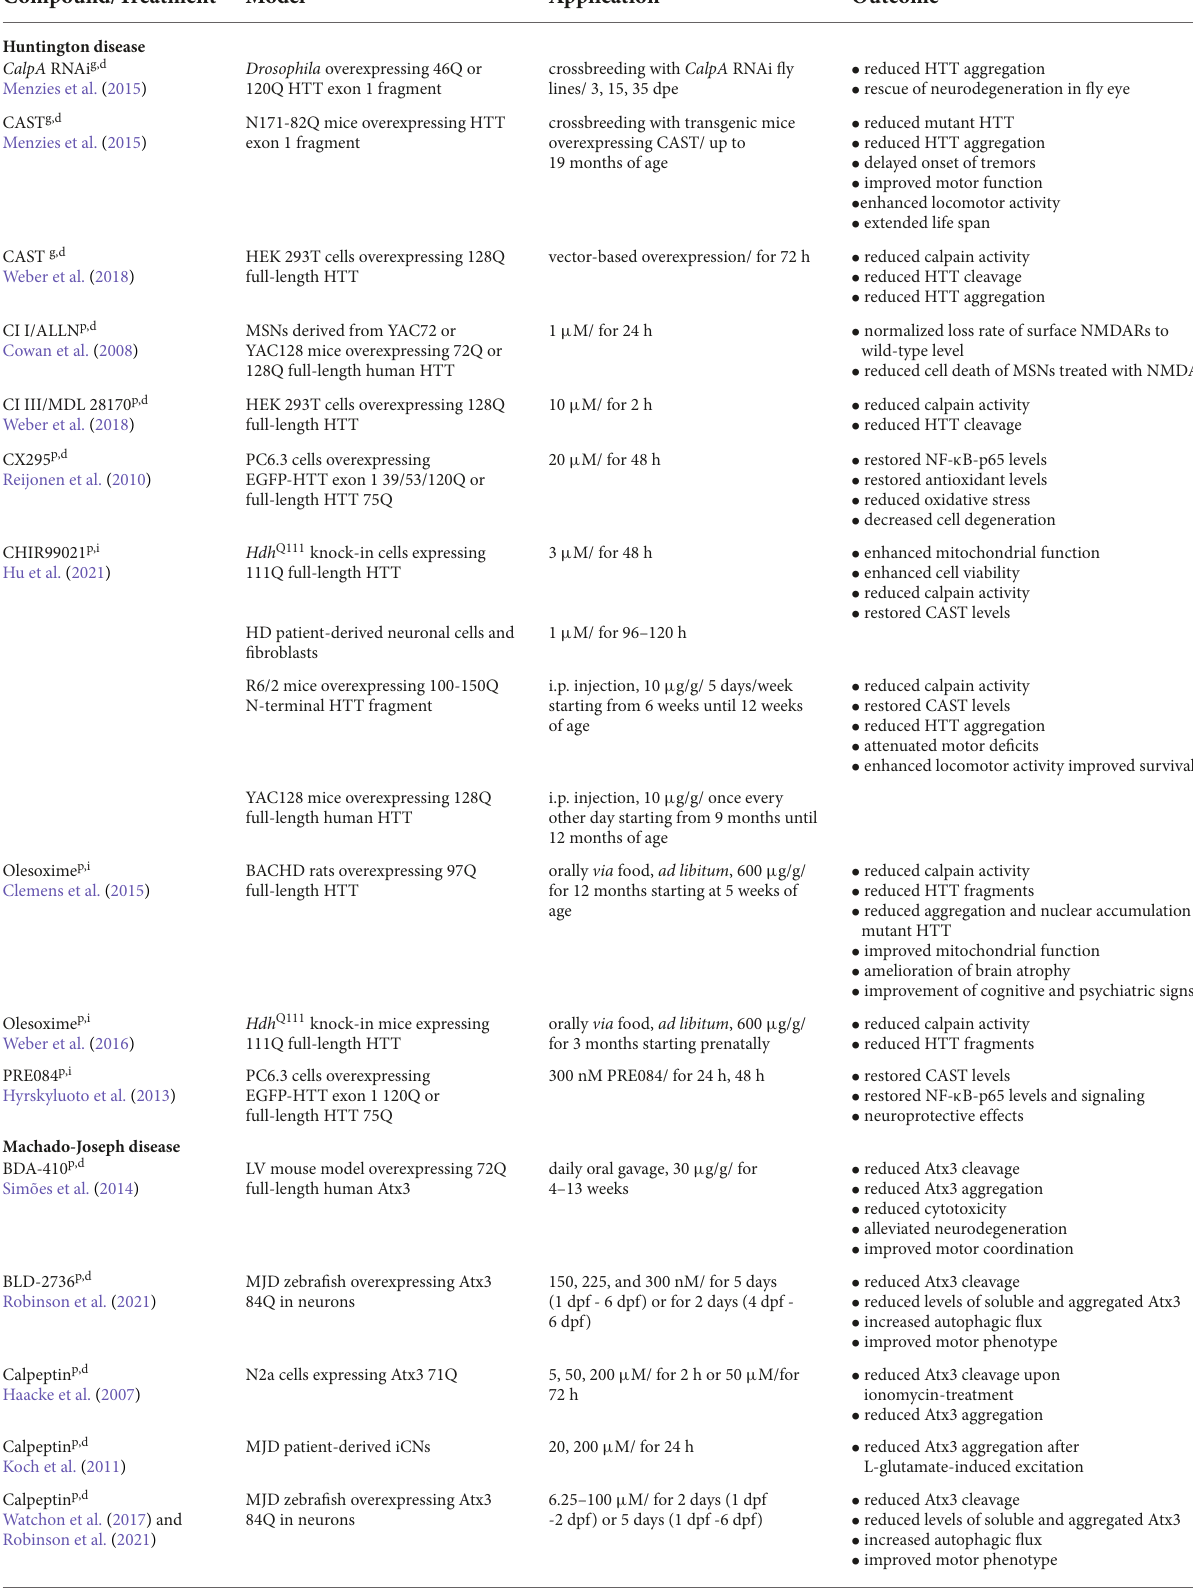
TABLE 2 Overview of preclinical studies targeting the calpain system in polyQ